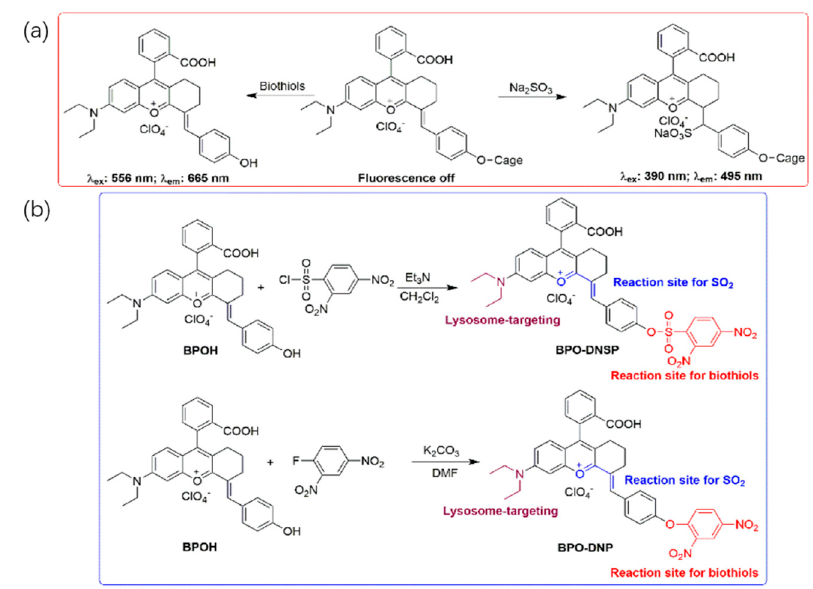
Scheme 1. Design strategy and synthesis routes of a lysosome-targeted fluorescent probe ( BPO-DNSP ) and BPO-DNP . ( a ) The reaction mechanisms of the fluorescent probe for SO 2 and biothiols; ( b ) Synthesis routes of BPO-DNSP and BPO-DNP . Molecules 2019 , 24 , x FOR PEER REVIEW